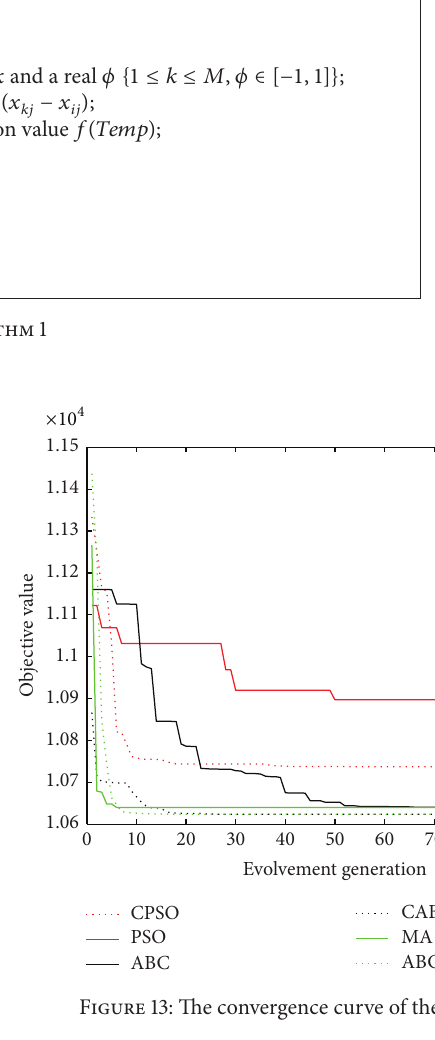
all of runs. The standard deviations for them are 5.6510𝑒 −